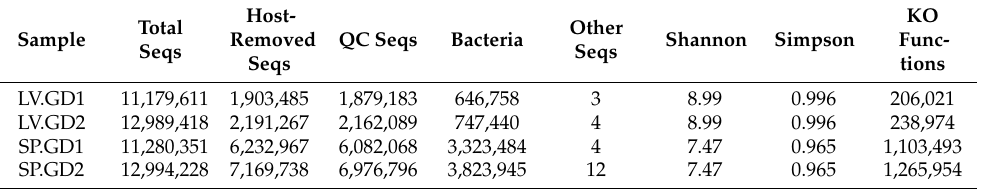
Table 1. Sample statistics determined following high-throughput shotgun sequencing on the Illumina HiSeq platform, sequence processing, taxonomic, and functional assignments. The total sequences before and after host sequence removal are shown, and the following quality checking through MG- RAST (v4.0.3). The sequences assigned to domain Bacteria through RefSeq. High-quality sequences that did not receive a taxonomic identity were listed as “Other Seqs”. Alpha diversity was determined for each sample based on the Shannon and Simpson metrics as implemented through QIIME (v1.9.1) at the species level of taxonomic resolution. The number of sequences assigned to a functional gene through KEGG Orthology (KO) was also